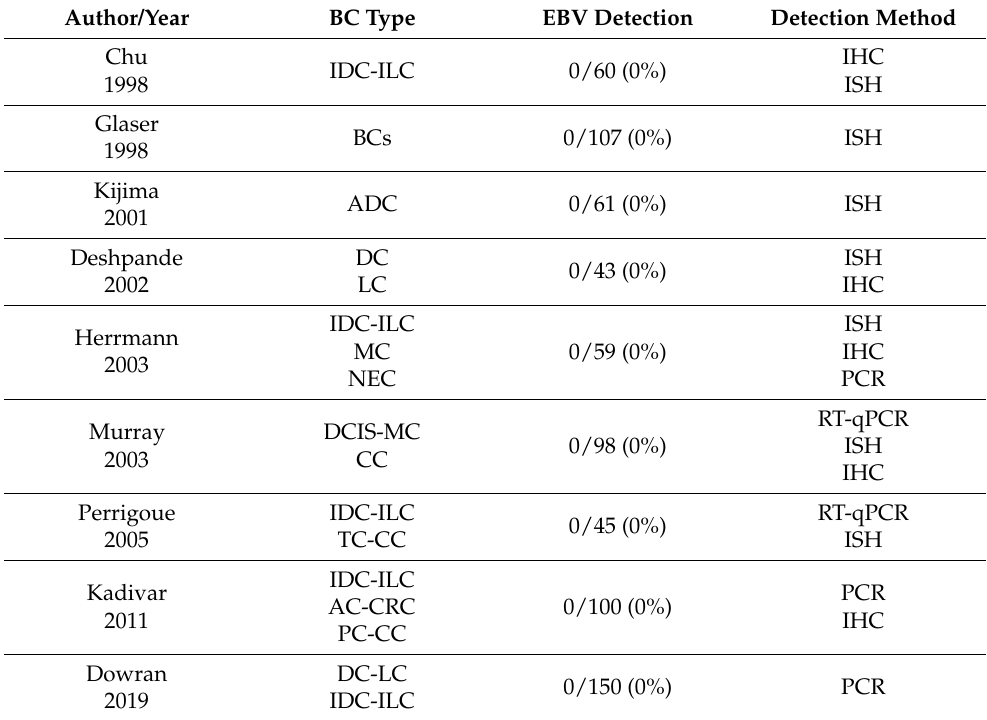
Table 2. Epstein–Barr virus absence in breast cancer